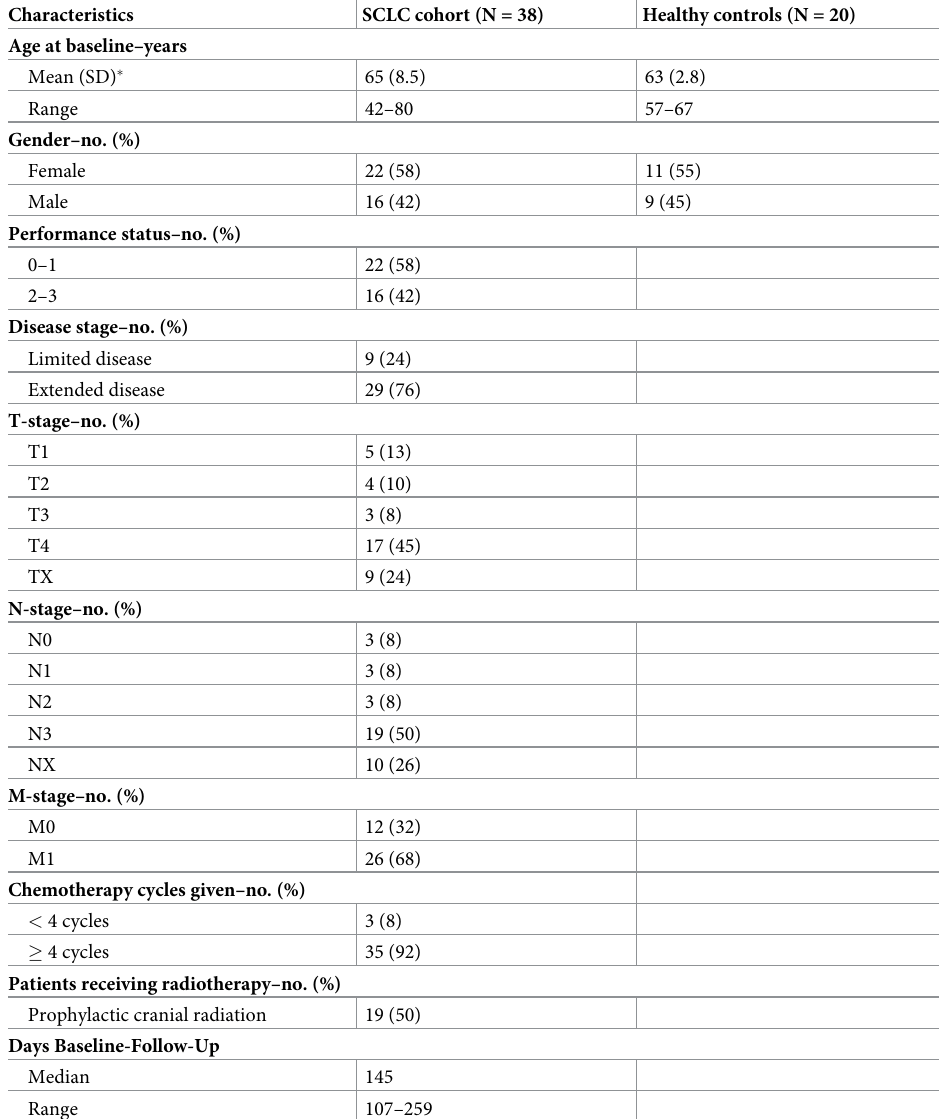
Table 1. Characteristics of small cell lung cancer patients at diagnosis. Characteristics SCLC cohort (N =